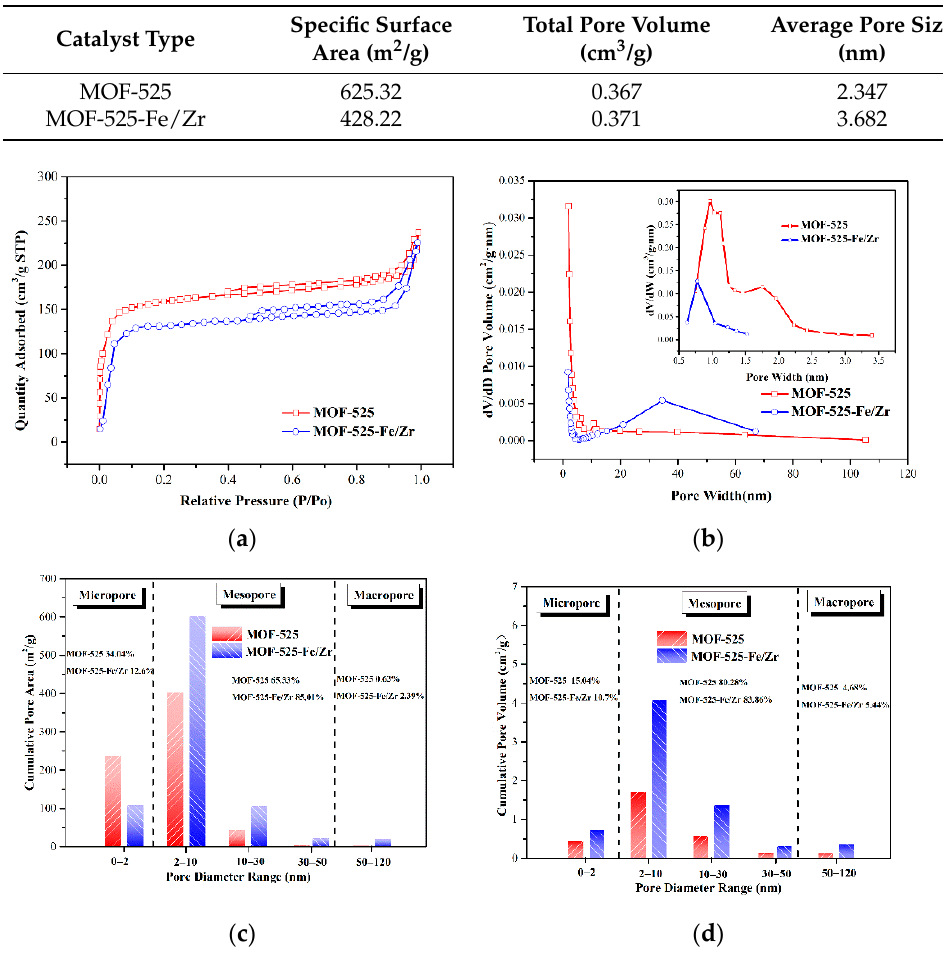
Figure 2. ( a ) N 2 adsorption isotherm; ( b ) pore size distribution; ( c ) incremental pore area; and ( d ) incremental pore volume of MOF-525 and MOF-525-Fe/Zr.